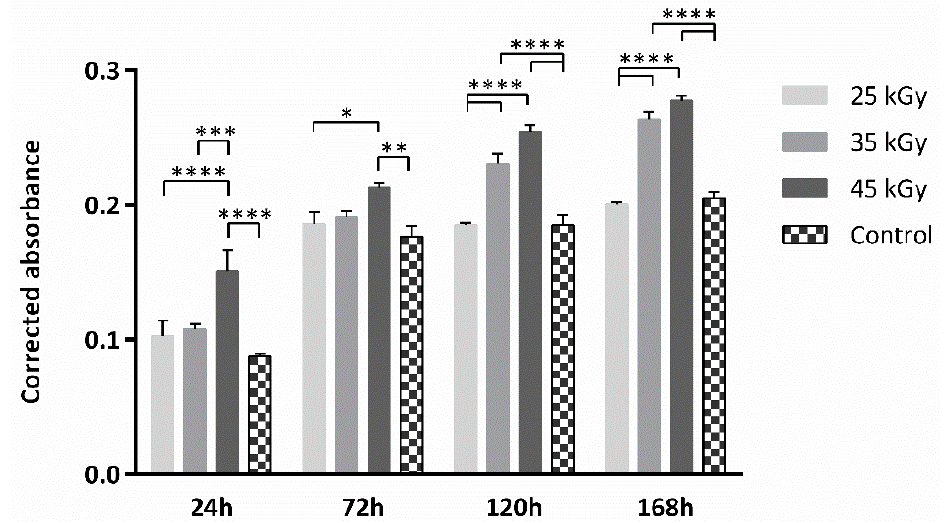
Figure 2. SEM images of gamma sterilized and unsterilized PCL scaffolds.